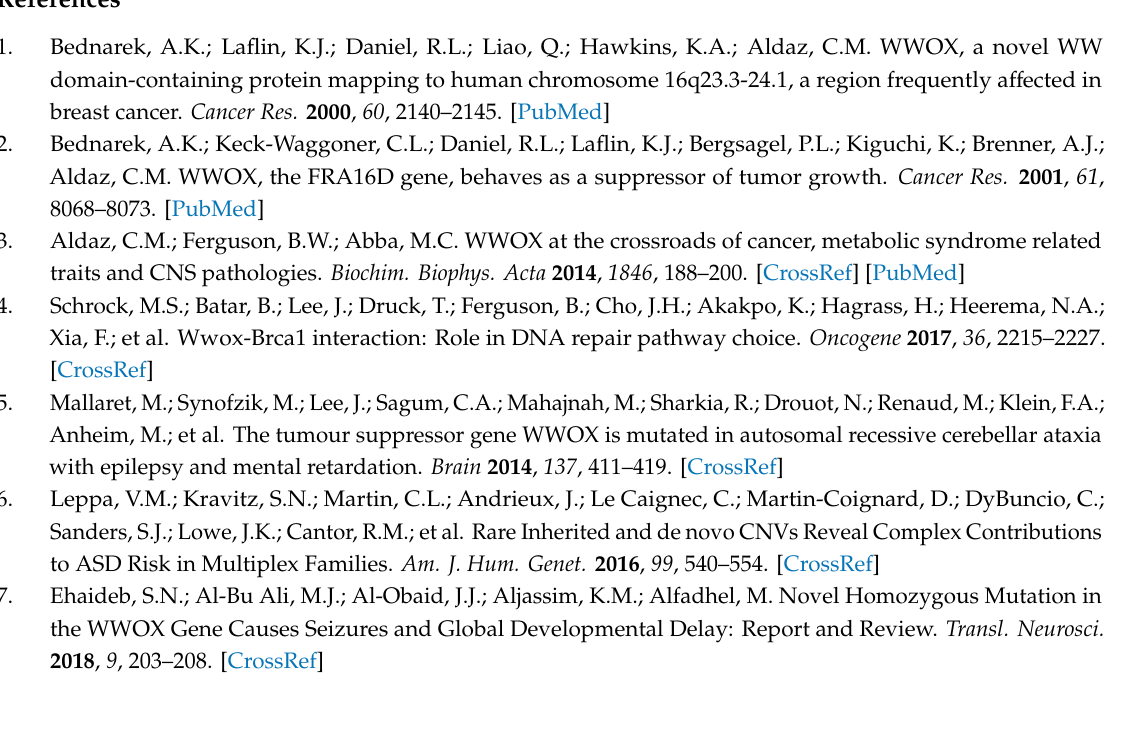
Table S1—Demographics, mutations, and clinical features of SCAR12 and WOREE cases. The gene duplication and deletion coordinates correspond to human genome assembly GRCh38 / hg38. Table S2—Summary of WWOX CNVs in ASD cases. The gene duplication and deletion coordinates correspond to human genome assembly GRCh38 /